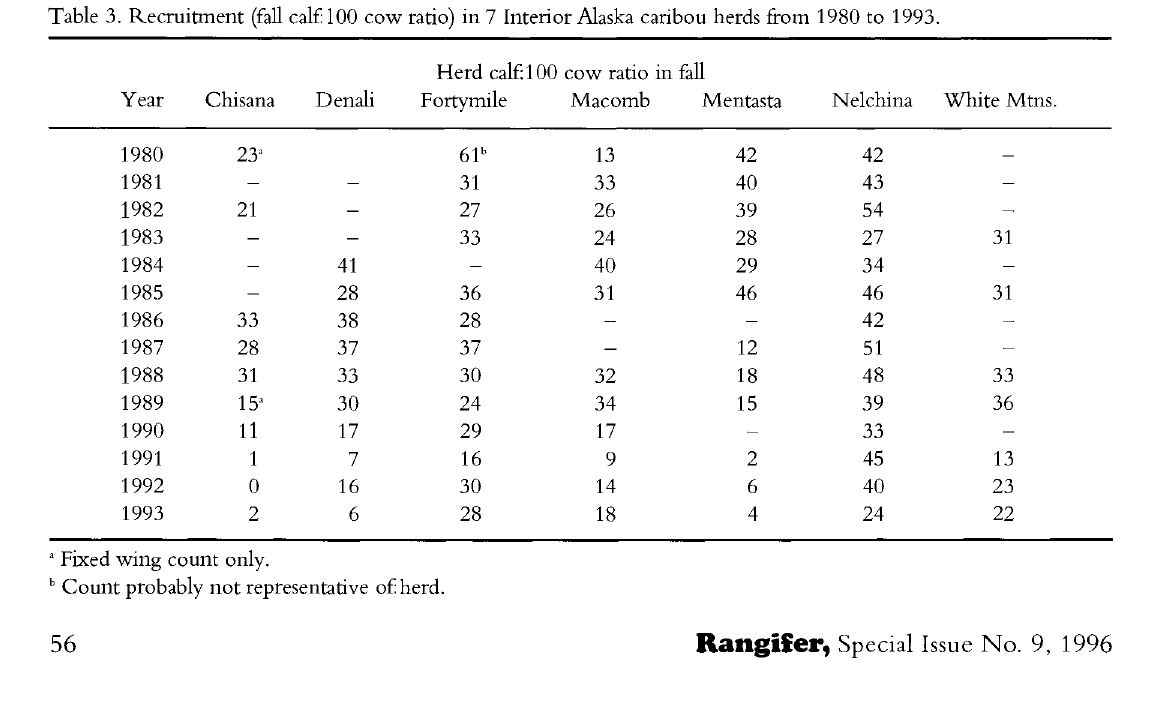
of 4- and 10-month-old female calves were sampled by immobilizing 9-15 animals from a helicopter in